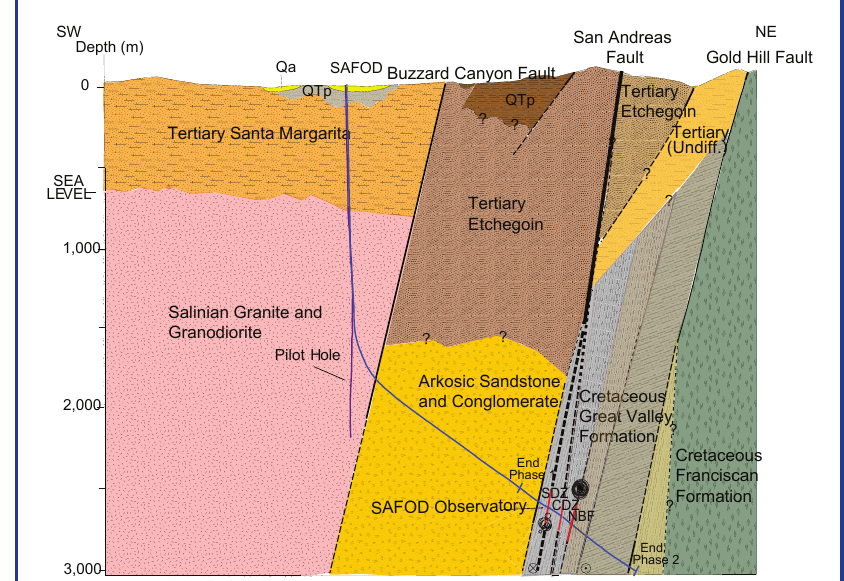
Figure 3. Simplified geologic cross-section parallel to the trajectory of the San Andreas Fault Observatory at Depth (SAFOD) borehole. The geologic units are constrained by surface mapping and the rock units encountered along both the main borehole and the pilot hole. The black circles represent repeating microearthquakes. The three notable fault traces associated with the San Andreas Fault damage zone (SDZ, CDZ, and NBF) are shown in red. The depth at which the SAFOD observatory is deployed is